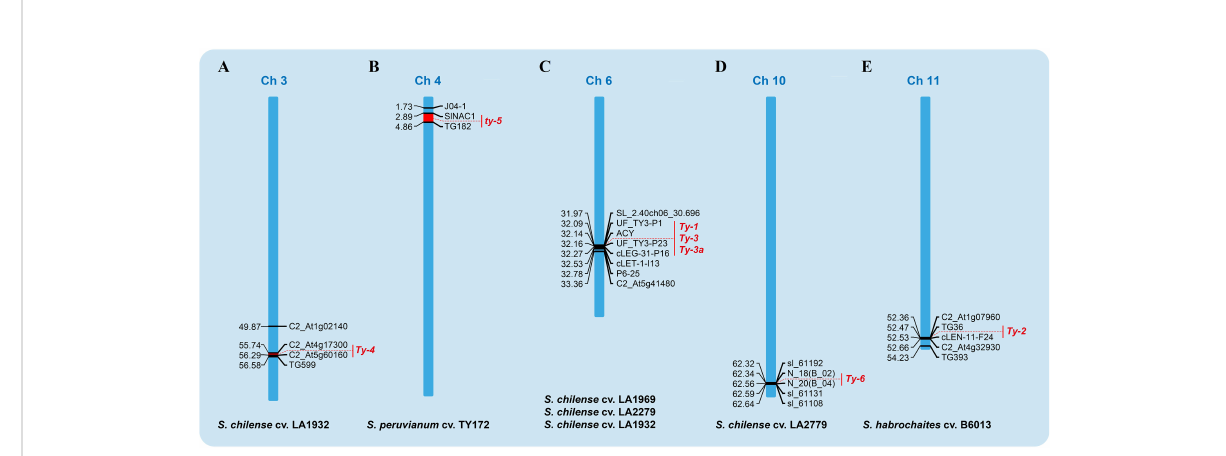
FIGURE 4 Mapping of TYLCV resistance genes on tomato chromosomes. (A) The site of Ty-4 on chromosome 3 of S. chilense cv., (B) the site of ty-5 on chromosome 4 of S. peruvianum cv., (C) the site of Ty-1 , Ty-3 and Ty-3a on chromosome 6 of S. chilense cv. (LA1969, LA2279 and LA1932 respectively), (D) the site of Ty-6 region on chromosome 10 of S. chilense (LA2279) and (E) the Ty-2 region on chromosome 11 of S. habrochaites